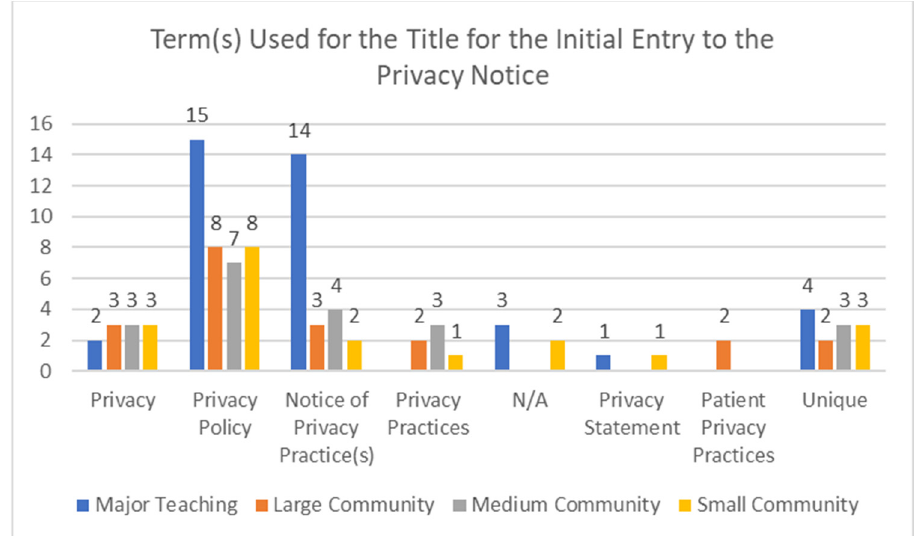
Figure 5. Term Used for the Title for the Initial